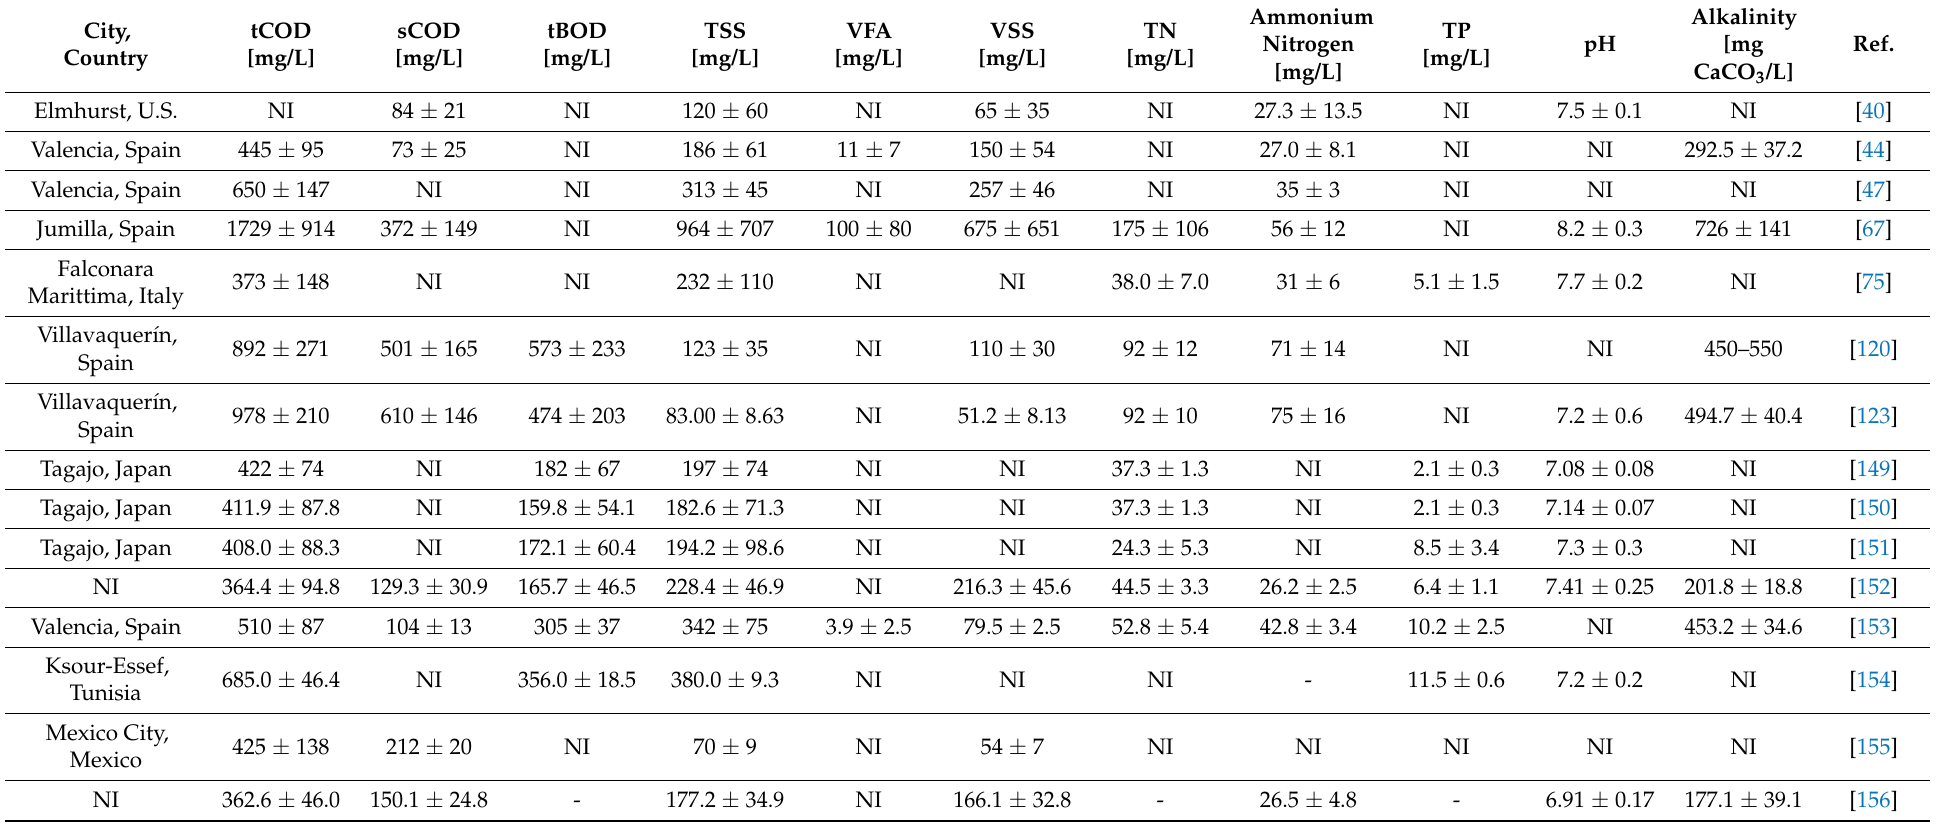
Table 3. The characteristics of real municipal wastewaters treated in